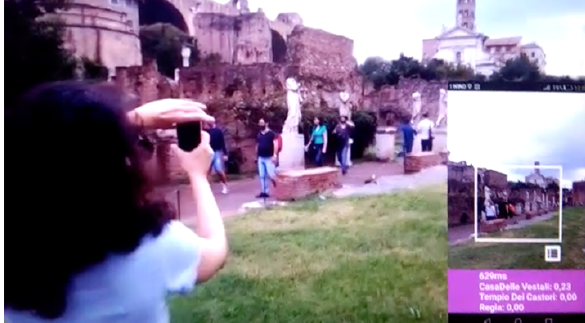
Figure 2. Field tests of an Android prototype of the recognition app (courtesy of Désirée Adiutori).